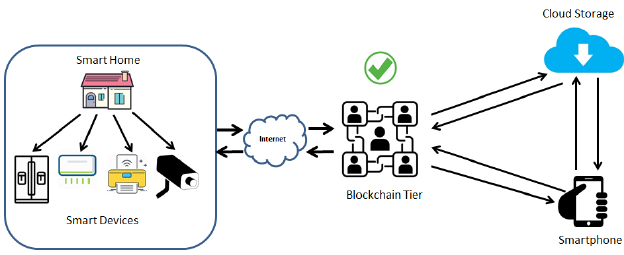
Figure 4. New IoT Architecture after adding Blockchain